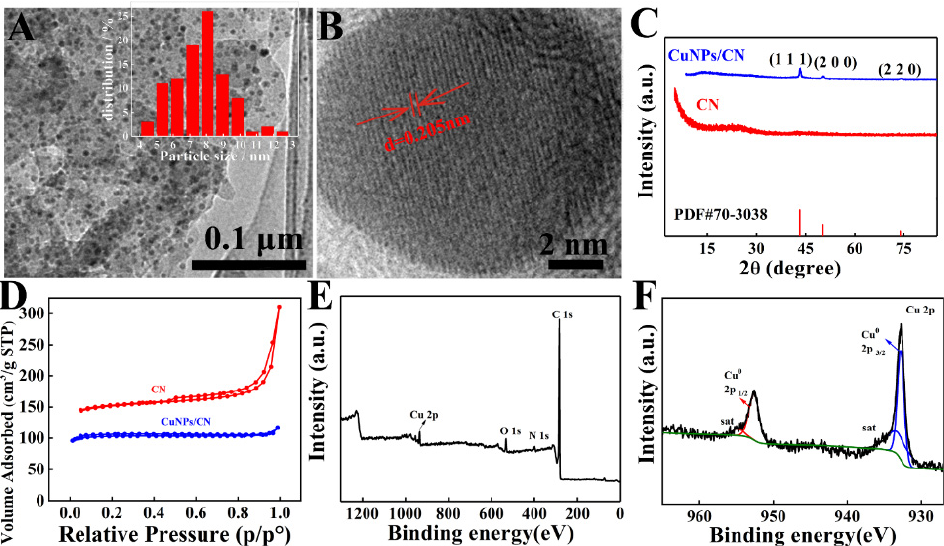
Figure 2. ( A ) TEM image of CuNPs/CN. ( B ) HRTEM image of CuNPs/CN. ( C ) XRD pattern of CuNPs/CN, CN and COF TD . ( D ) N 2 -adsorption/desorption isotherm of CuNPs/CN, CN and COF TD . ( E ) XPS pattern of CuNPs/CN. ( F ) Fine XPS spectrum of Cu 2p. Inset in Figure 2A: Particle size distribution of CuNPs.